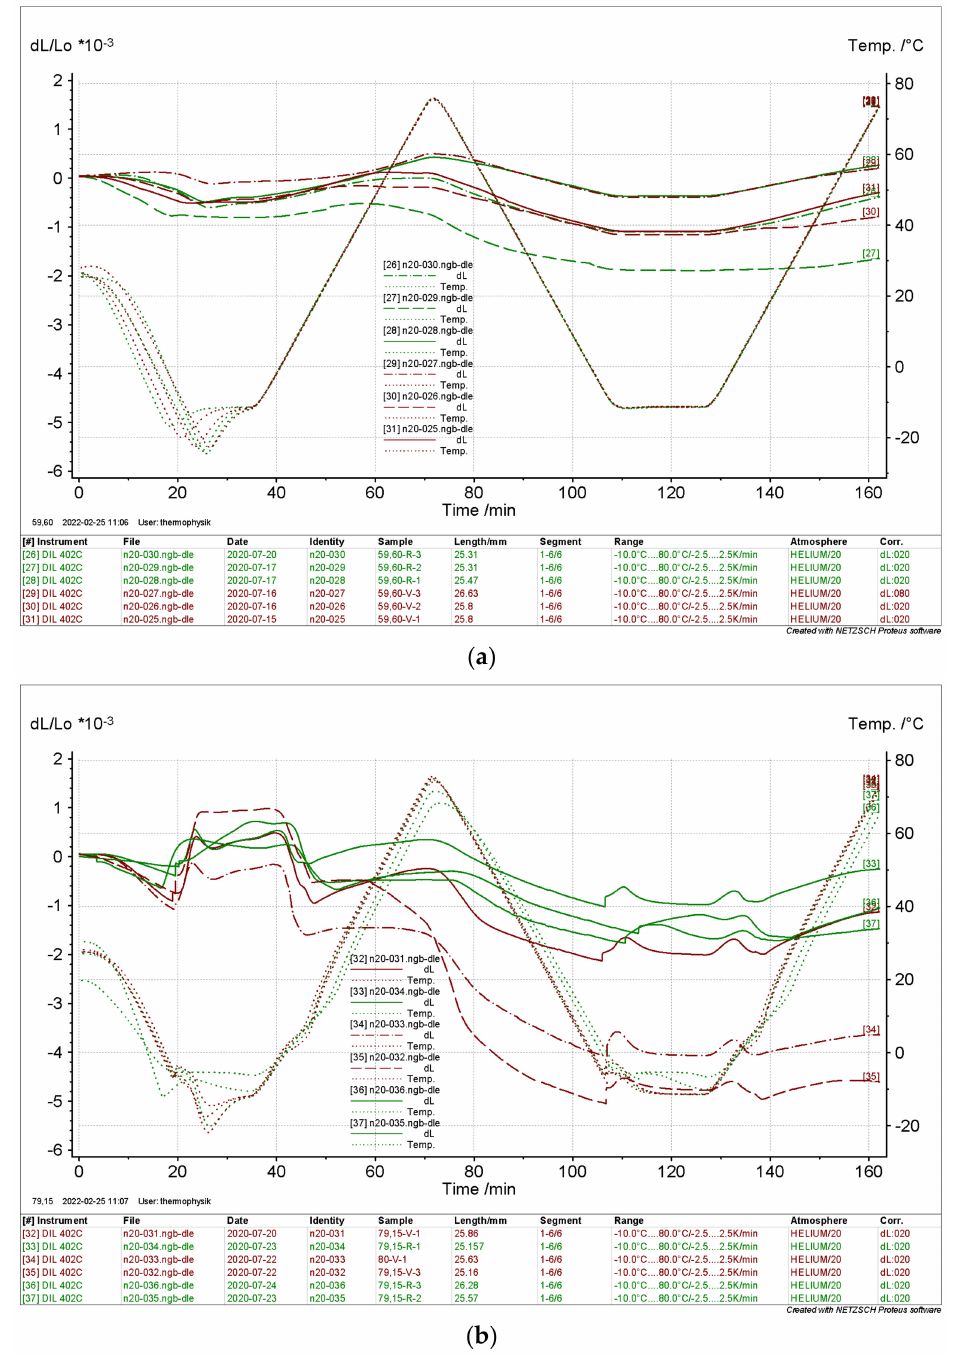
Figure 12. Results of the relative linear thermal expansion of the moist drill core samples from depths of ( a ) 59.6 m and ( b ) 79.15